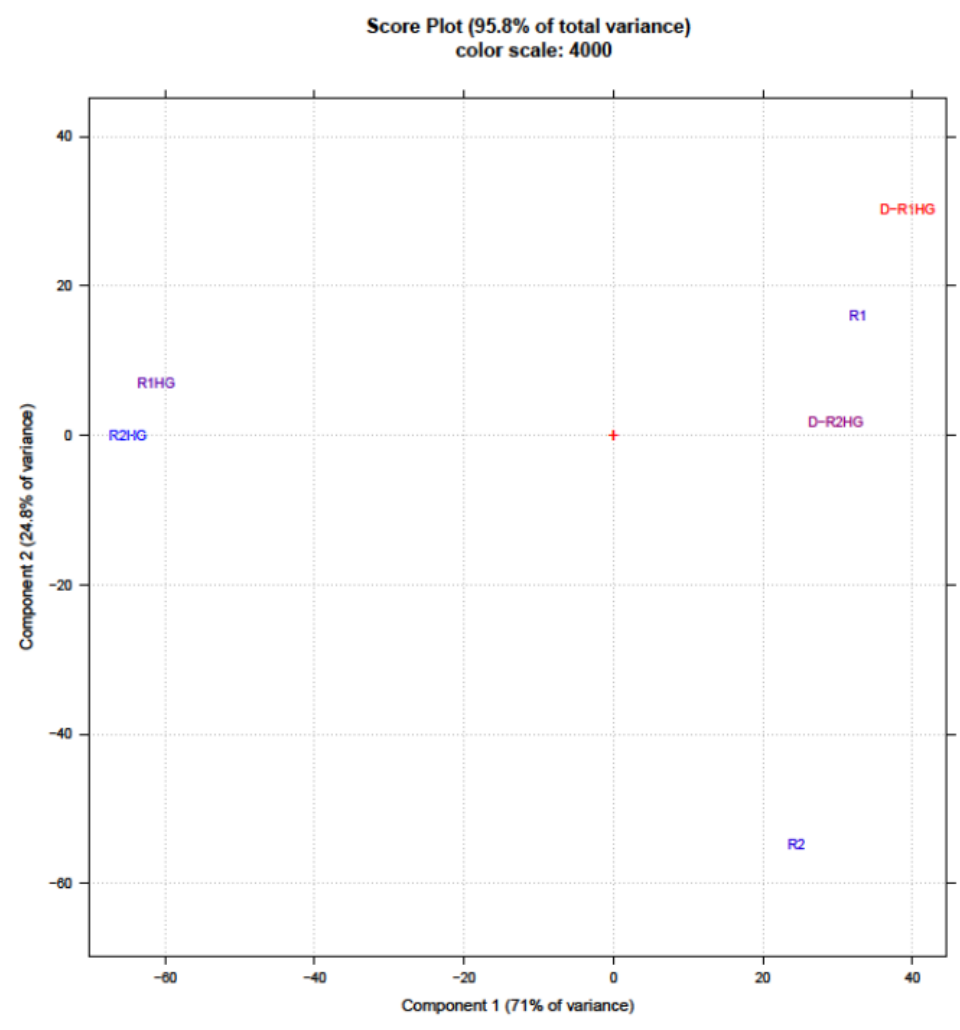
Figure 5. Results by PCA performed on the matrix collecting spectral data of R1, R2, R1HG, R2HG, D-R1HG, and D-R2HG, represented as score plot of PC1 vs. PC2.